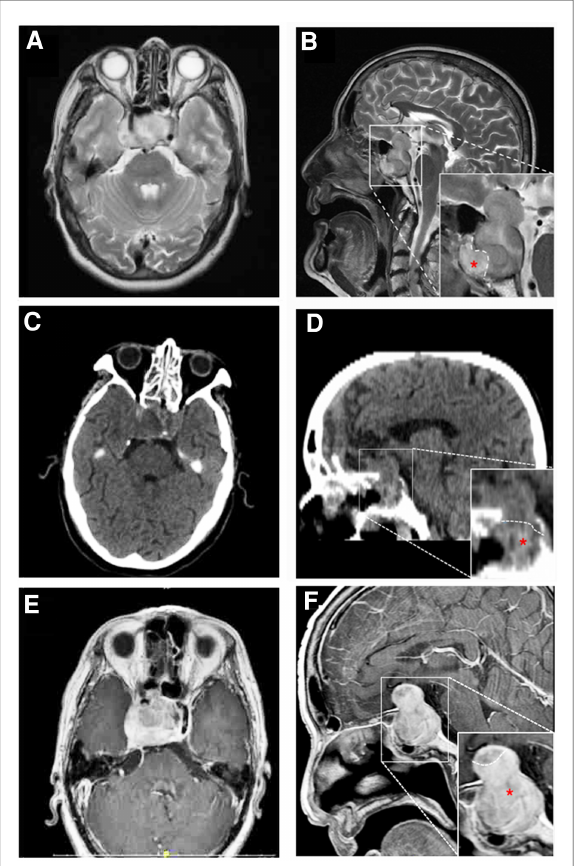
FIGURE 1 MRI ( A,B,E,F ) and CT ( C,D ) fi ndings in a patient with pituitary adenoma (PA) and concurrent malignant triton tumor (MTT) in sellar area. On 20 days before the operation, axial image ( A ) and saggittal ( B ) T2-weighted images revealed that the lesion is consisted of two distinctive components with a clear border. The upper and lower components were histologically diagnosed as pituitary adenoma and MTT (red asterisk), respectively. Four days after the operation, axial ( C ) and saggittal ( D ) CT images showed that MTT component was totally removed, while residual PA could be seen in suprasellar area. Fifty-six days after the operation, axial ( E ) and saggittal ( F ) contrast-enhanced MR images revealed that MTT has